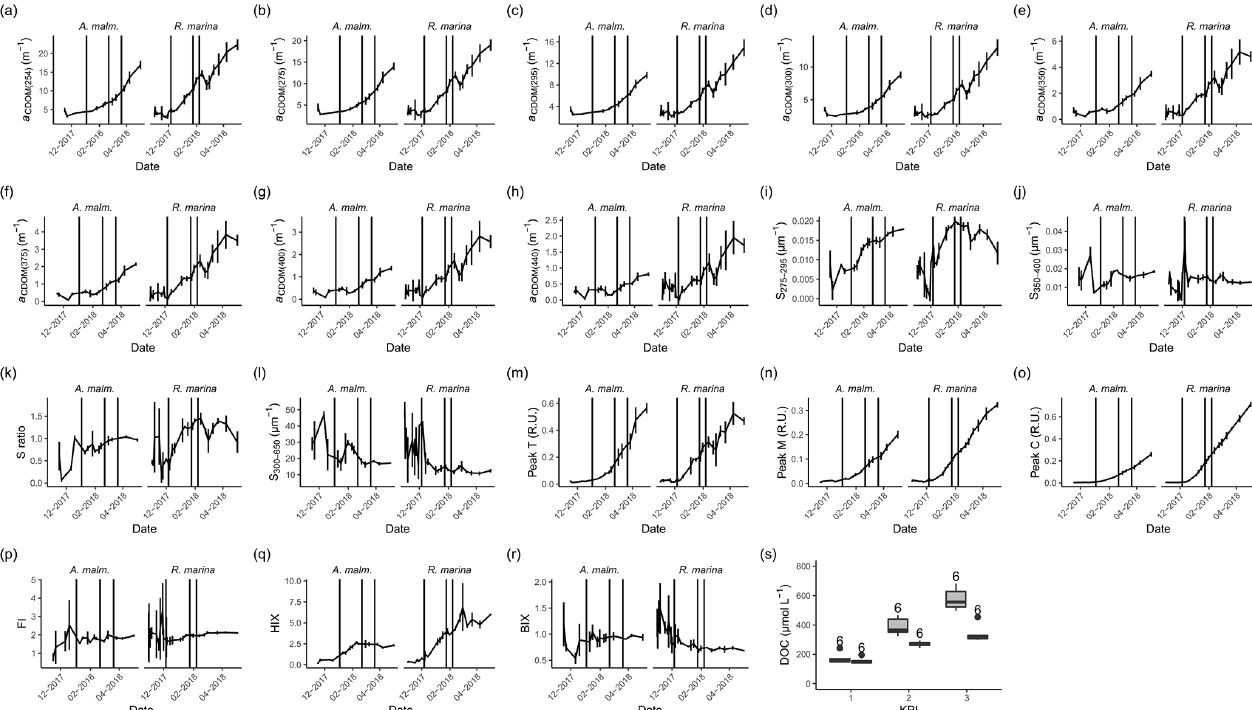
Figure A1. CDOM and FDOM variables in phytoplankton cultures during the DOM release experiment. (a–h) Absorption coefficients at different wavelengths. (i, j, l) Spectral slopes between different wavelength ranges. (k) Ratio of spectral slopes between 275–295 and 350– 400nm (Helms et al., 2008). (n) Peak M, marine humic-like DOM (Coble, 1996). (p) FI, fluorescence index (Mcknight et al., 2001). (q) HIX, humification index (Zsolnay et al., 1999). (r) BIX, biological index (Huguet et al., 2009). (s) DOC concentration at each KPI. Vertical lines from left to right in each panel mark the times of the first, second, and third KPIs. Error bars indicate 1 standard deviation. The number above the boxplots shows the number of measurements. Lower and upper hinges of boxes mark the first and third quartiles, respectively, while the whiskers extend to the lowest and the highest values within 1.5 times the interquartile range. Grey boxes (left) show A. malmogiense , and white boxes (right) show R. marina